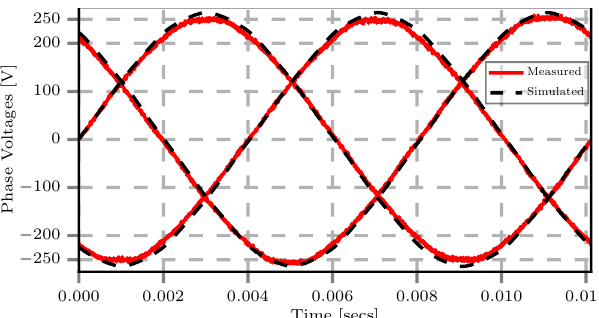
Figure 27. Open-circuit phase voltage waveforms at rated